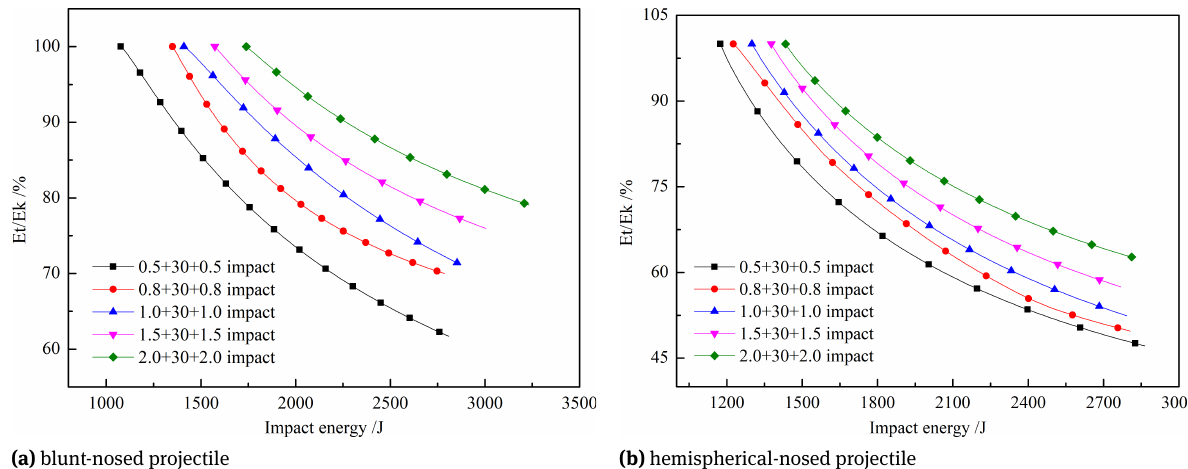
Figure 13: Variation of impact energy versus percentage absorbed through sandwich plates